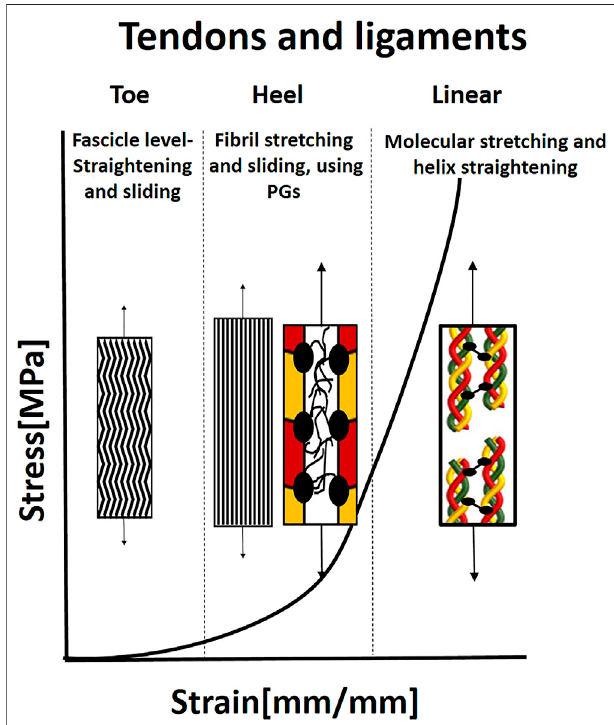
FIGURE 6 | Illustration of the J-shaped behavior and mechanical mechanisms in tendon and ligaments. In the toe region, the microscopic crimpinginthefasciclesisstraightened.Whenthe fi brilsarestraight,theystart carrying the load, and simultaneous sliding and stretching start, mediated by PGs, in the heel region. In the linear region, the molecular stretch ofthecovalentcross-linksandhelix straighteningoccurs. BasedonFratzland Weinkamer